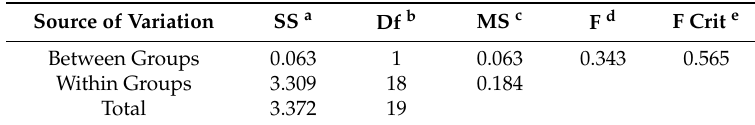
Table 4. Comparison of HZR and HZB in terms of total content of Quercetin, Ugonin J, and Ugonin M using ANOVA